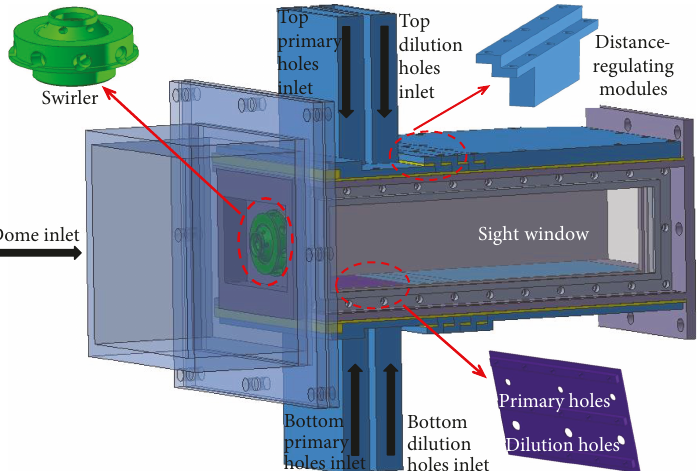
Figure 1: Geometry of the combustor model.